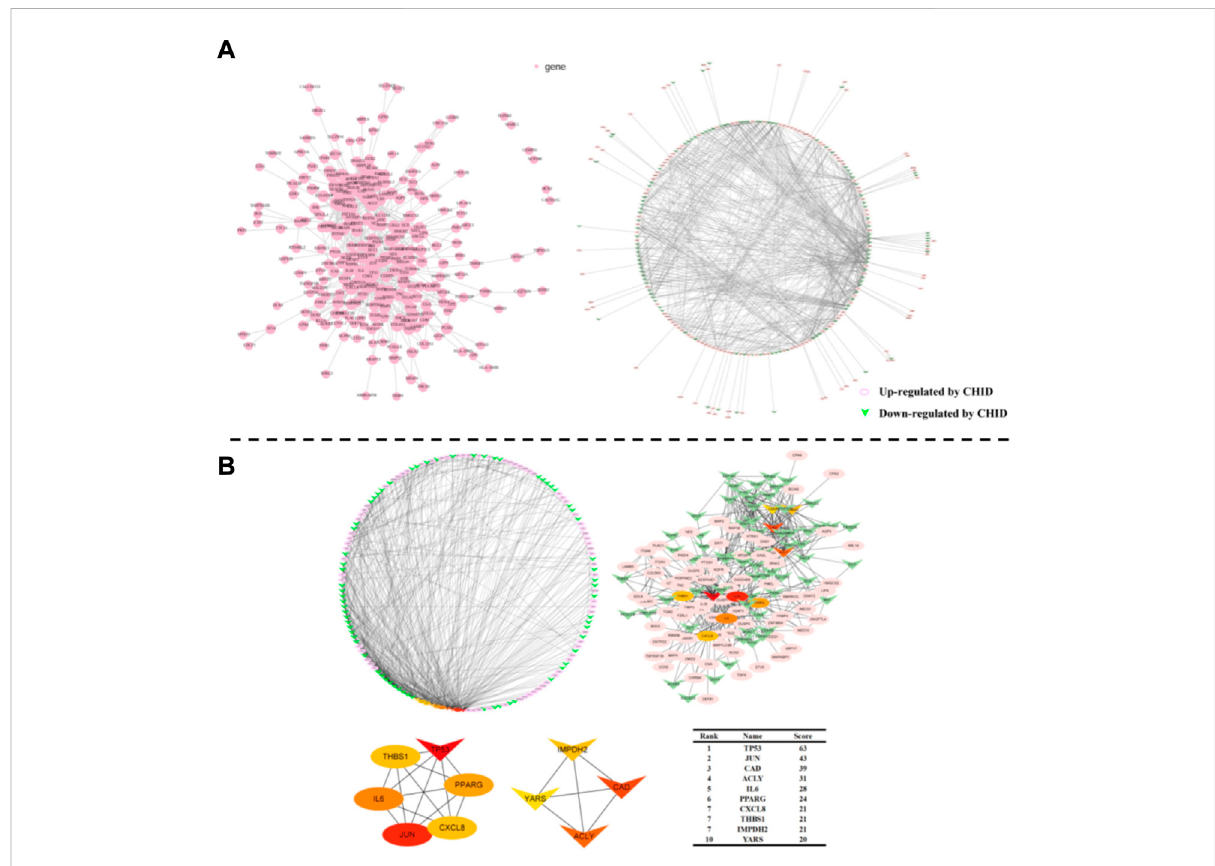
FIGURE 5 (A) : Protein-Protein Interaction Network Analysis Chart. PPI network exported from STRING and visualized in Cytoscape. A node represents a gene. The genes increased in MCF-7 by Chidamide were shown in pink color; at the same time, the genes that down-regulated in MCF-7 by Chidamidewerepostedintriangles. (B) :Selectionofhubgenes.PPInetworkwasanalyzedbyCytoHubba,apluginofCytoscape.Anoderepresentsa gene. The hub genes with higher scores were demonstrated with the larger